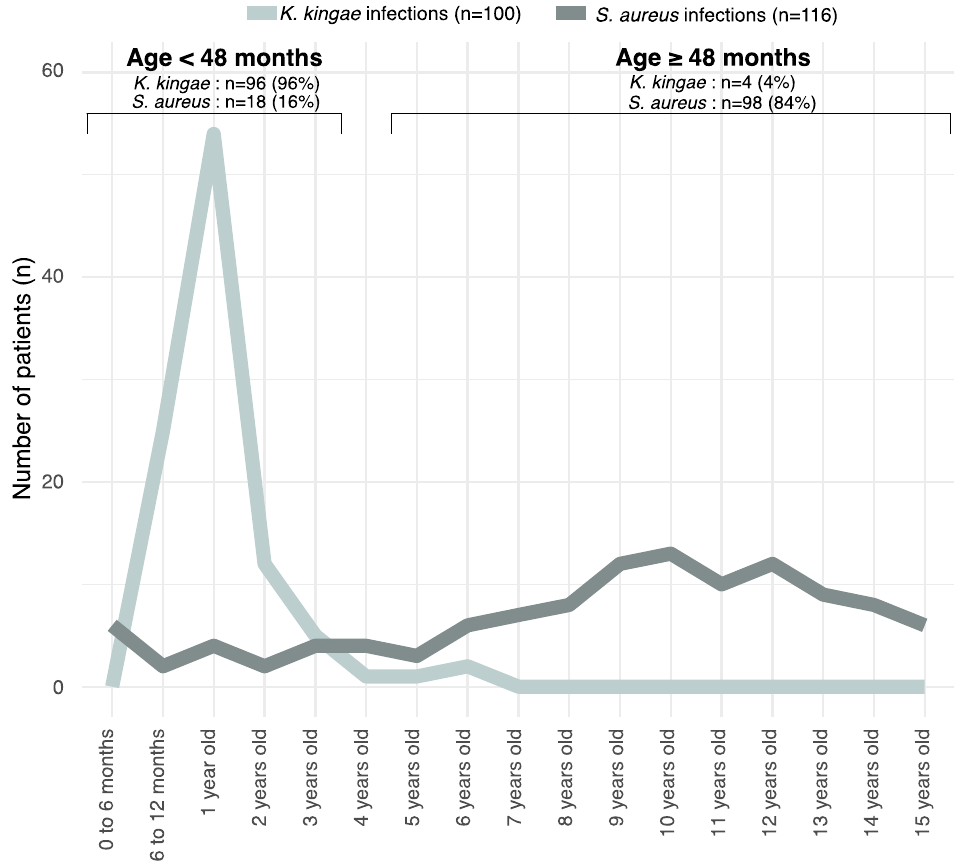
Figure 2. K. kingae mostly caused septic arthritis and primarily affected the knee.